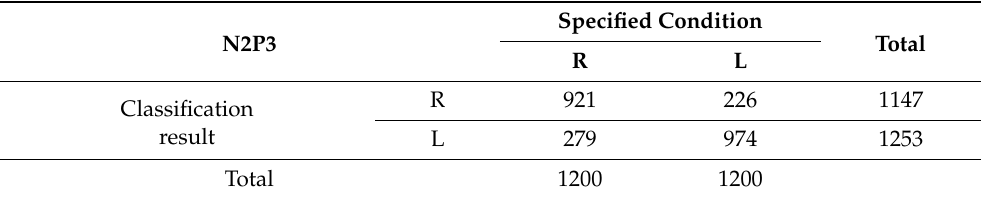
Table 15. The frequency distribution of sound stimuli in the right and left ear using the NN technology to classify the data gained from component